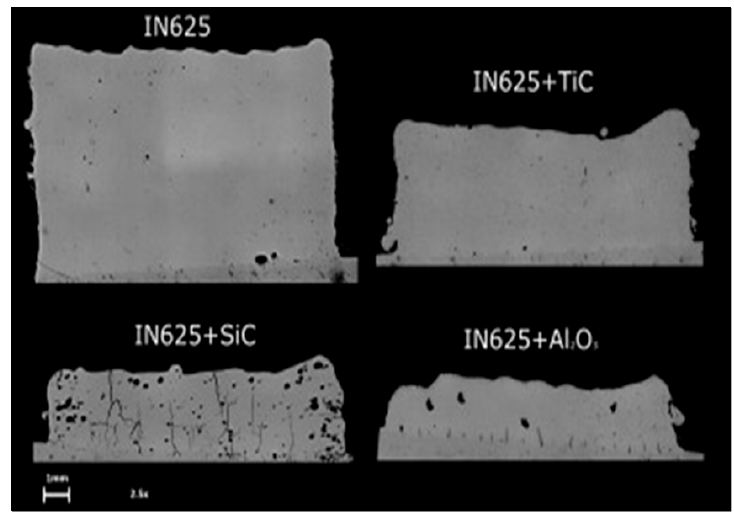
Figure 21. X-Section of DLD IN625( top left ); IN625 + TiC ( top right ); IN625 + SiC ( bottom left ); IN625 + Al 2 O 3 ( bottom right ) (adapted with permission from Ref. [68] 2013, Elsevier).